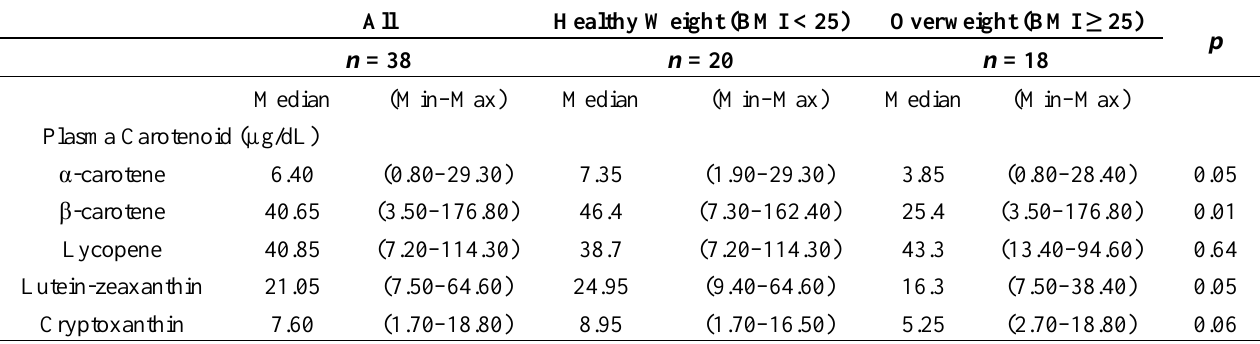
Table 2. Summary statistics (median, minimum and maximum) for plasma carotenoids, food frequency questionnaire (FFQ) carotenoids and fruit and vegetable intake, by weight